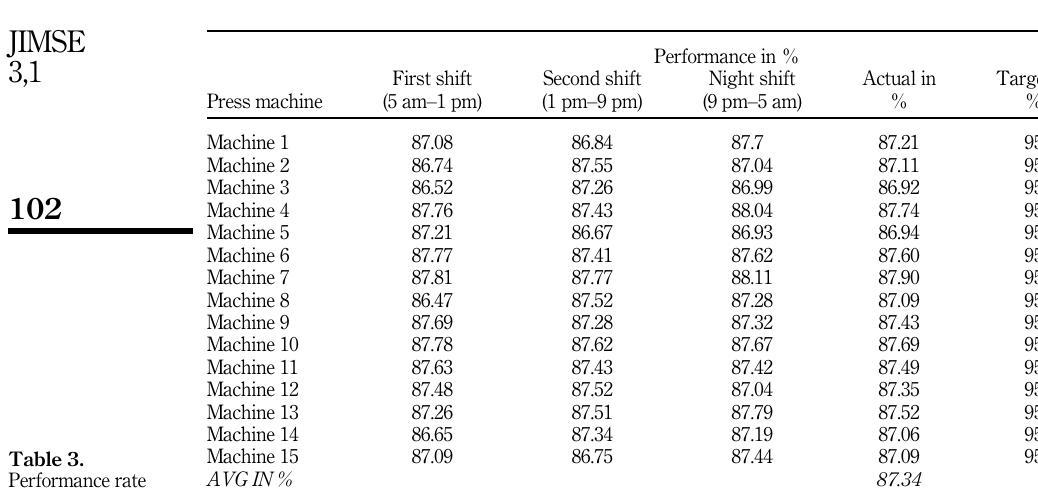
Table 3. Performance rate